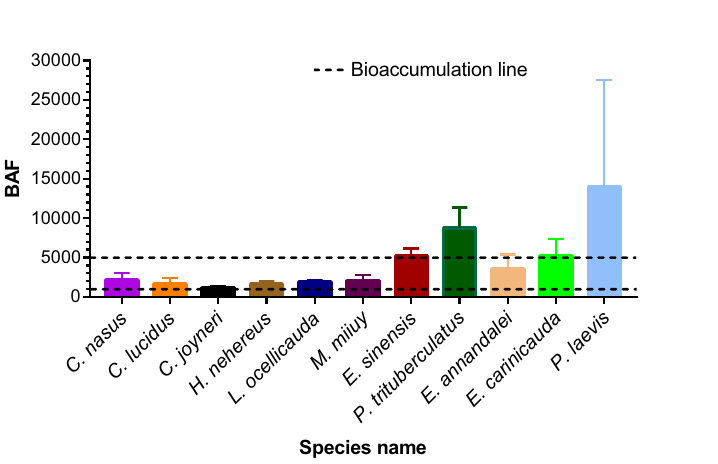
Figure 3. Hierarchical cluster analysis based on the Euclidean distance of the metals in selected species.